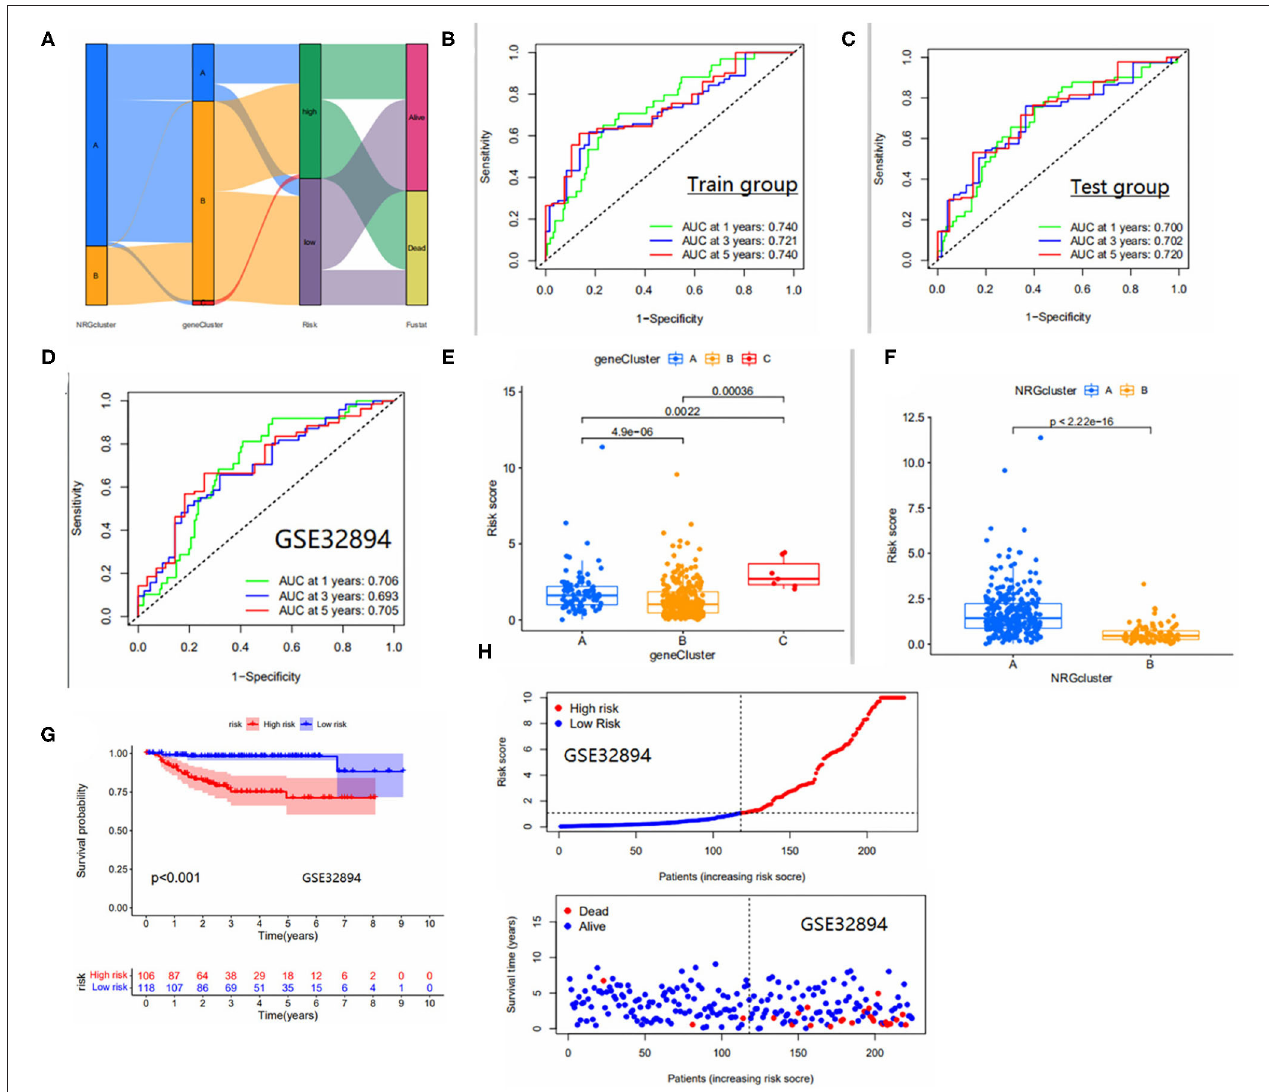
FIGURE 4 | (A) Distribution of the two NRGS subtypes and three genetic subtypes between high and low risk groups. (B–D) Area under the ROC curve for the Train group/test group, GSE32894 cohort. ROC curves to predict the sensitivity and specificity of 1-, 3-, and 5-year survival according to the risk_score. (E) Differences in risk scores between gene subtypes. (F) Differences in risk scores between NRGS subtypes. (G) Survival curves for high and low risk groups in the GSE32894 cohort. (H) Risk curves for high and low risk groups in the GSE32894 cohort. Ranked dot and scatter plots showing the risk_score distribution and patient survival